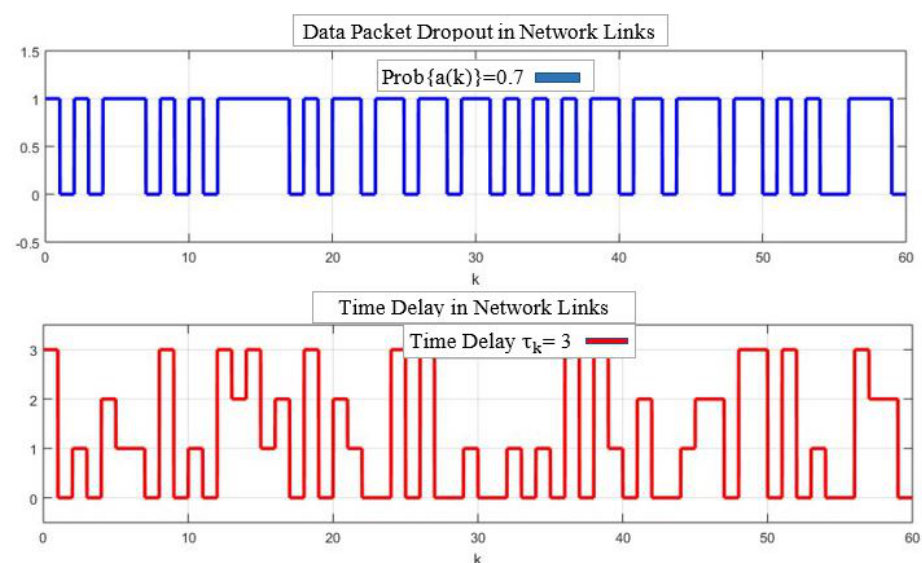
Figure 4. Network-induced stochastic faults α ( k ) with ¯ α ( k ) = 0.6 and time-delay τ k = 3.